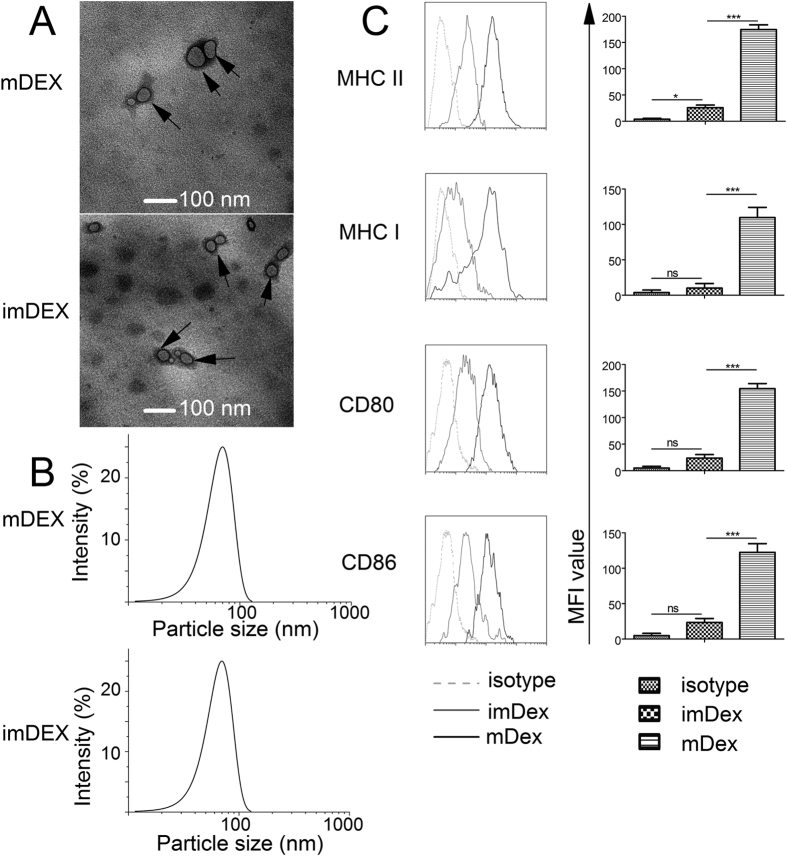
Characterization of exosomes derived from DCs.(A) Two types of exosomes were observed by electron microscopy. Bar represents 100 nm. Arrows indicate exosomes. Representative fields are shown. (B) Particle size of exosomes (mDex is 73.8 ± 20.8 nm; imDex is 69.9 ± 18.0 nm). (C) The phenotypic profiles of imDex and mDex were analysed by cytofluorometry. The results shown are representative of three independent experiments. (D) Mean fluorescence intensity (MFI) was analysed. *Indicates p < 0.05; ***indicates p < 0.001; ns indicates no significant difference.